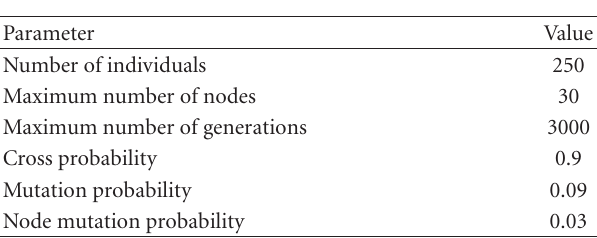
Table 1: GP parameter settings.